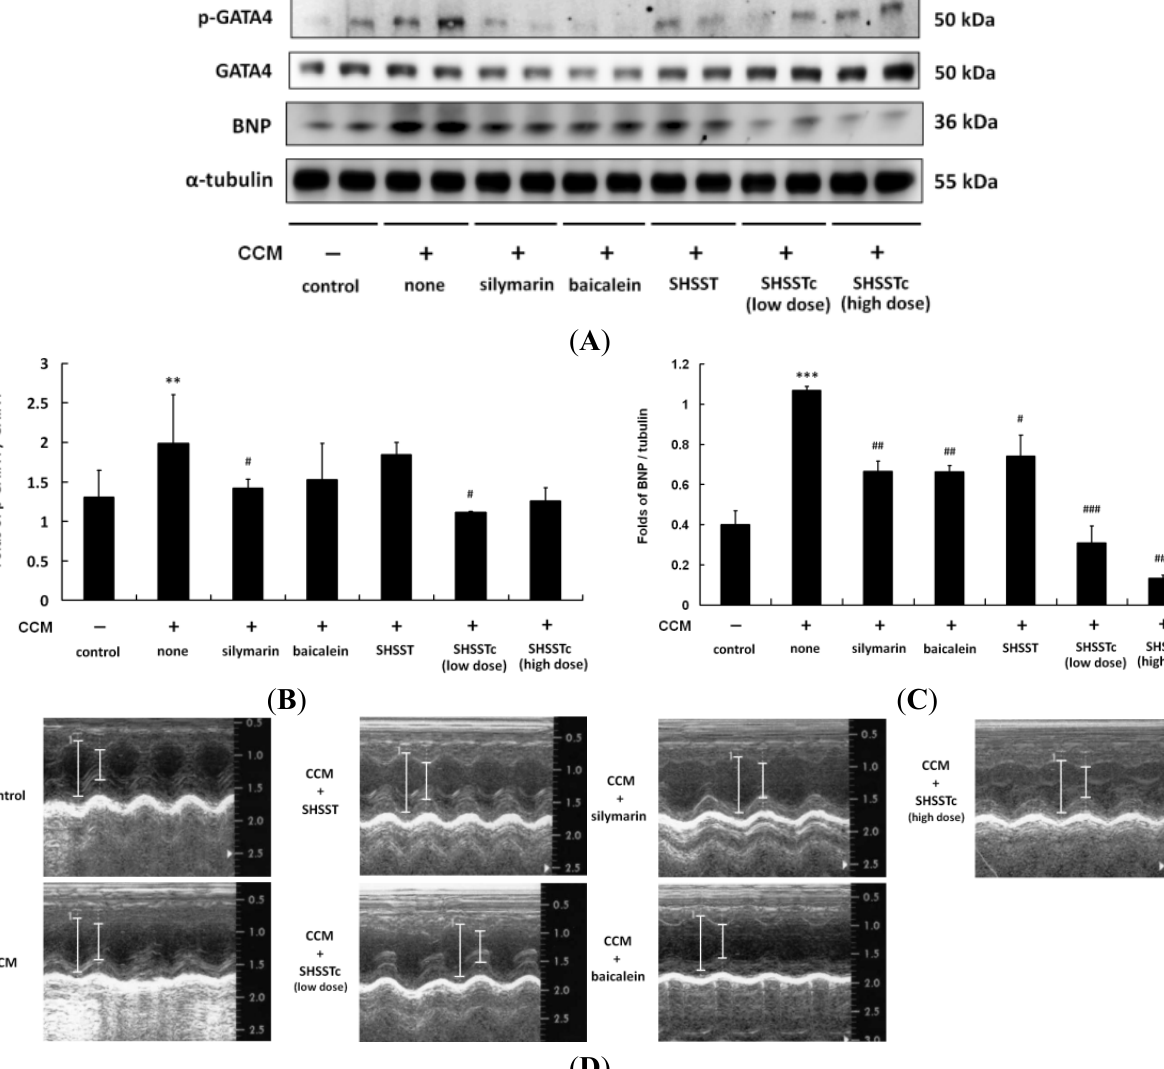
Figure 1. Phoshphorylated GATA binding protein 4 (p-GATA4) and brain